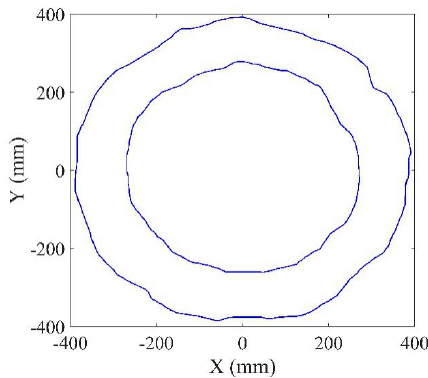
Figure 7. The boundary curve in the XY plane.